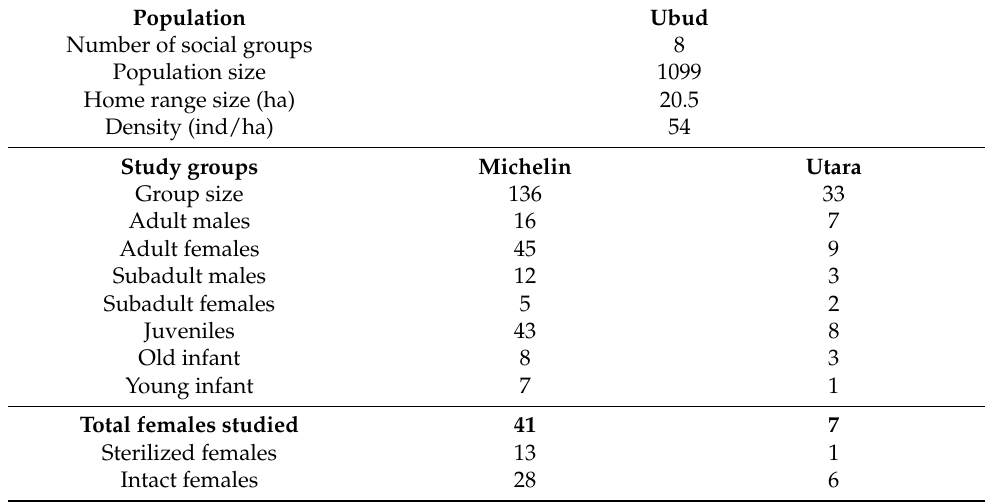
Table A1. Demographic status of the macaque population and composition of the two study groups (Michelin and Utara) in Ubud Monkey Forest in March 2020 (i.e., at the end of the study period); with number of studied intact and sterilized females.